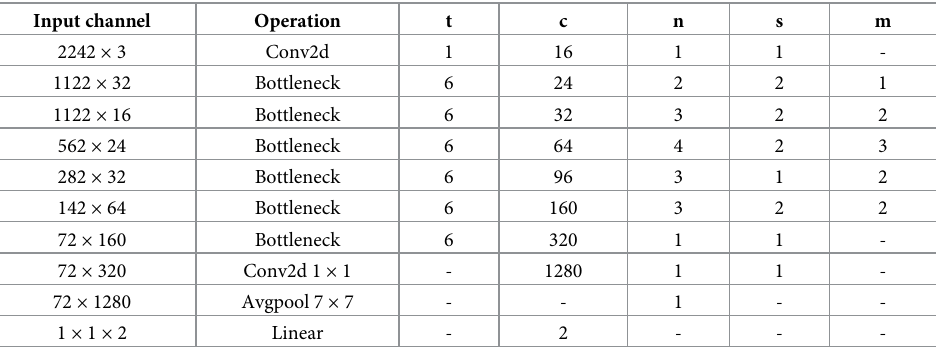
Table 1. Structure of MobileNet-TSM.